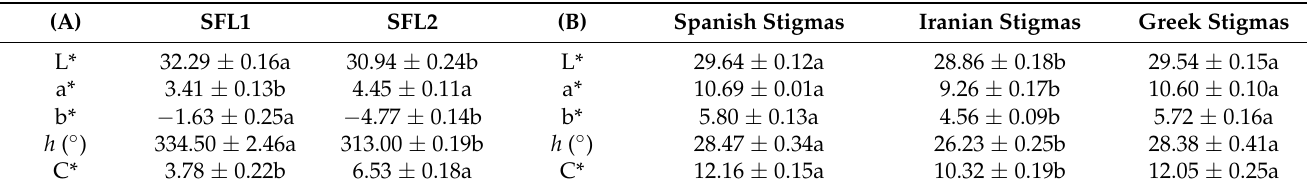
Table 3. Color parameters of the powdered saffron floral by-products ( A ) and saffron stigmas ( B ) 1